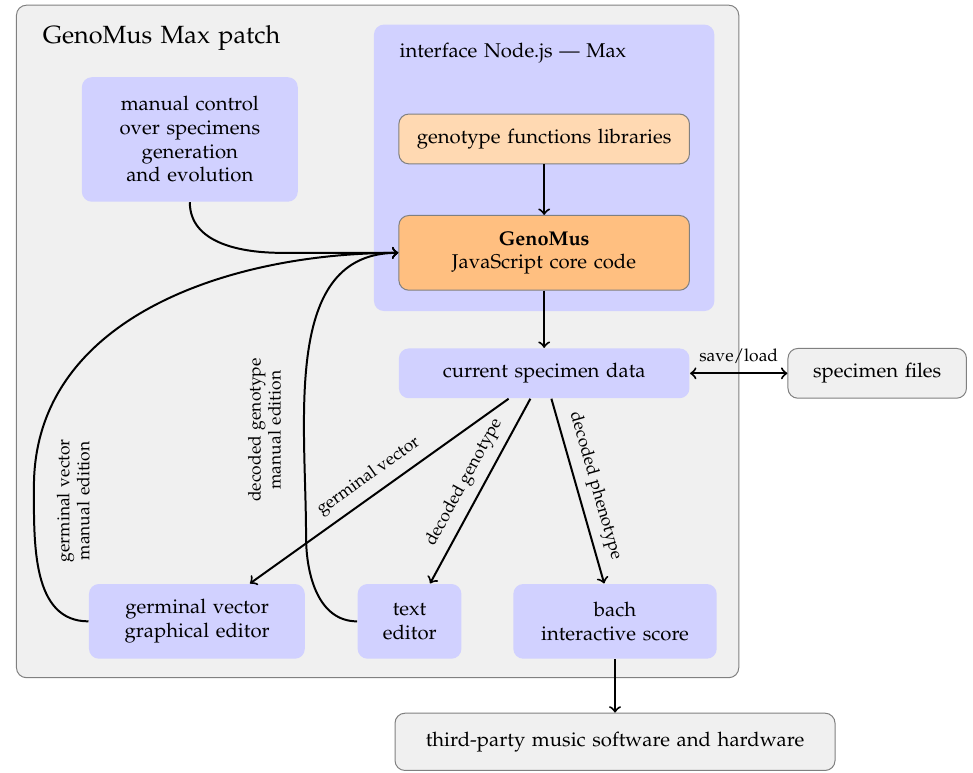
Figure 2. Overview of the environment designed to interact with the GenoMus generative